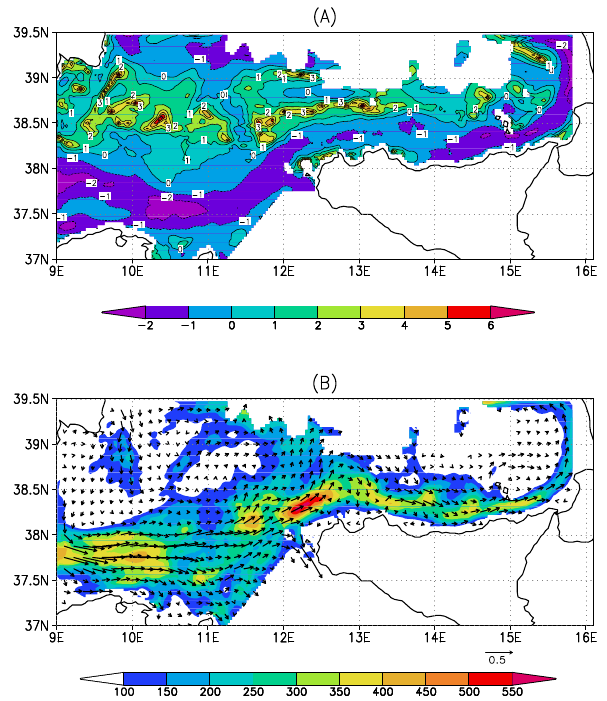
Fig. 6. Monthly mean map of Sardinia – Tyrrhenian sub-region for Φ in November (panel A ) and of the mean flow overlapped to EKE (panel B , [ms − 1 ] and [cm 2 s − 2 ] respectively) in February. Areas with EKE higher than 100cm 2 s − 2 are shaded